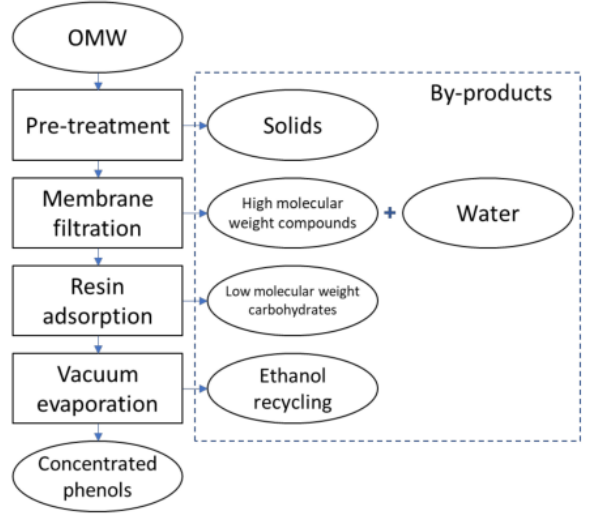
Figure 15. The combined treatment system for the recovery of phenols from OMW [235].